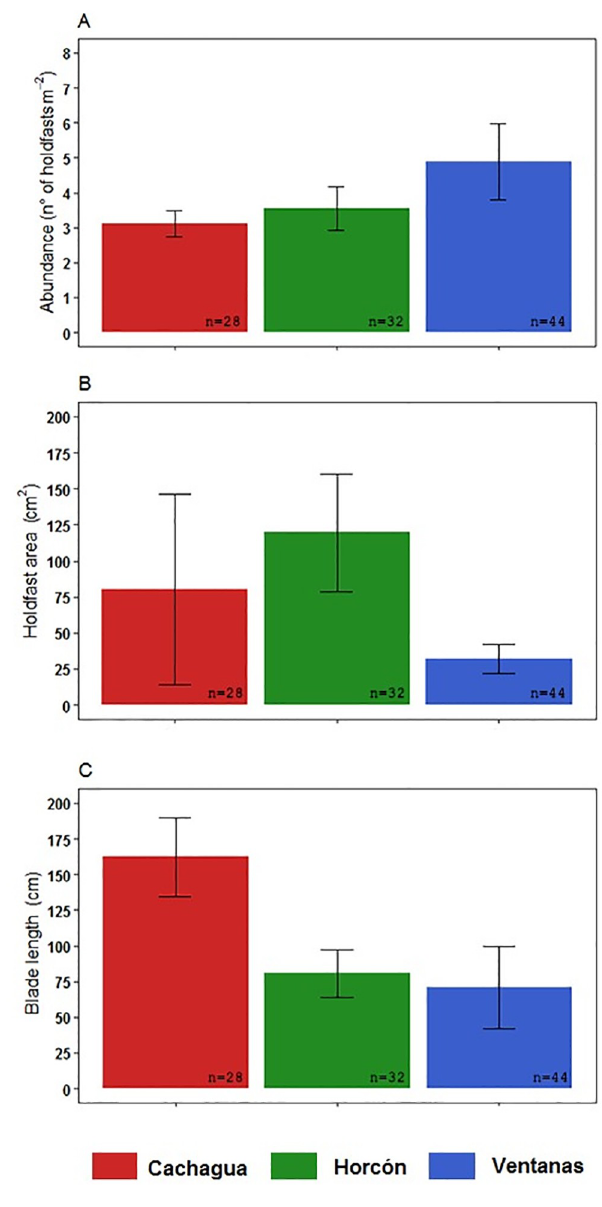
Fig 2. Comparison of morphological features. Average of A) abundance, B) holdfast area, and C) length of the longest blade of Lessonia spicata population from Cachagua, Horco´n and Ventanas.